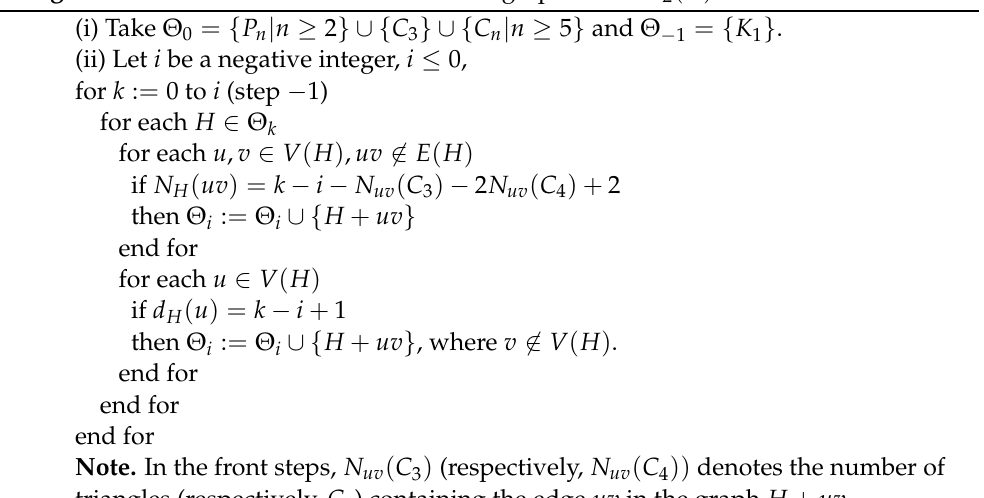
Algorithm 2: Construction of all connected graphs with Π 2 ( G ) = i